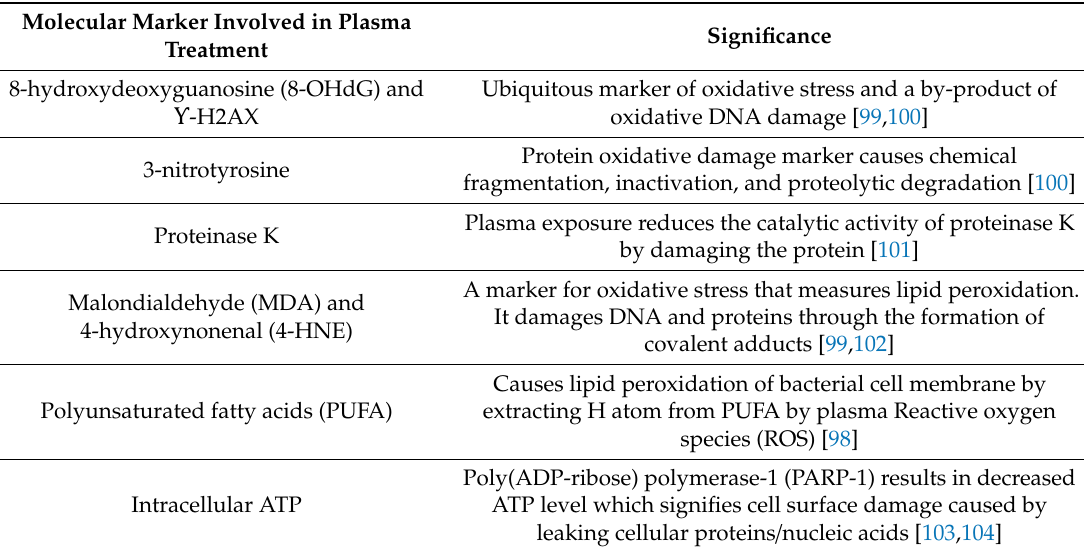
Table 3. Molecular markers involved in plasma treatment.